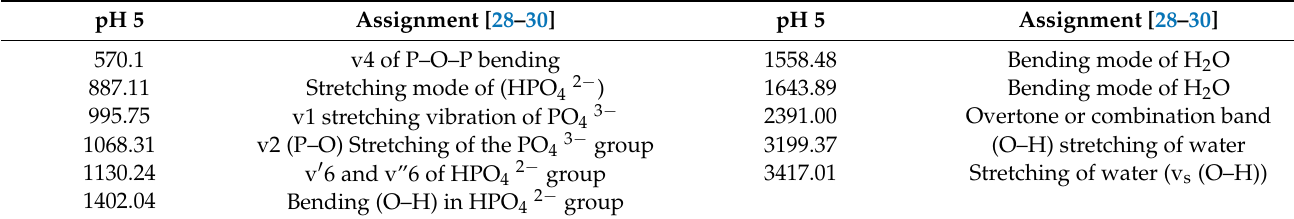
Table 4. Characteristic transmittance infrared bands of brushite.